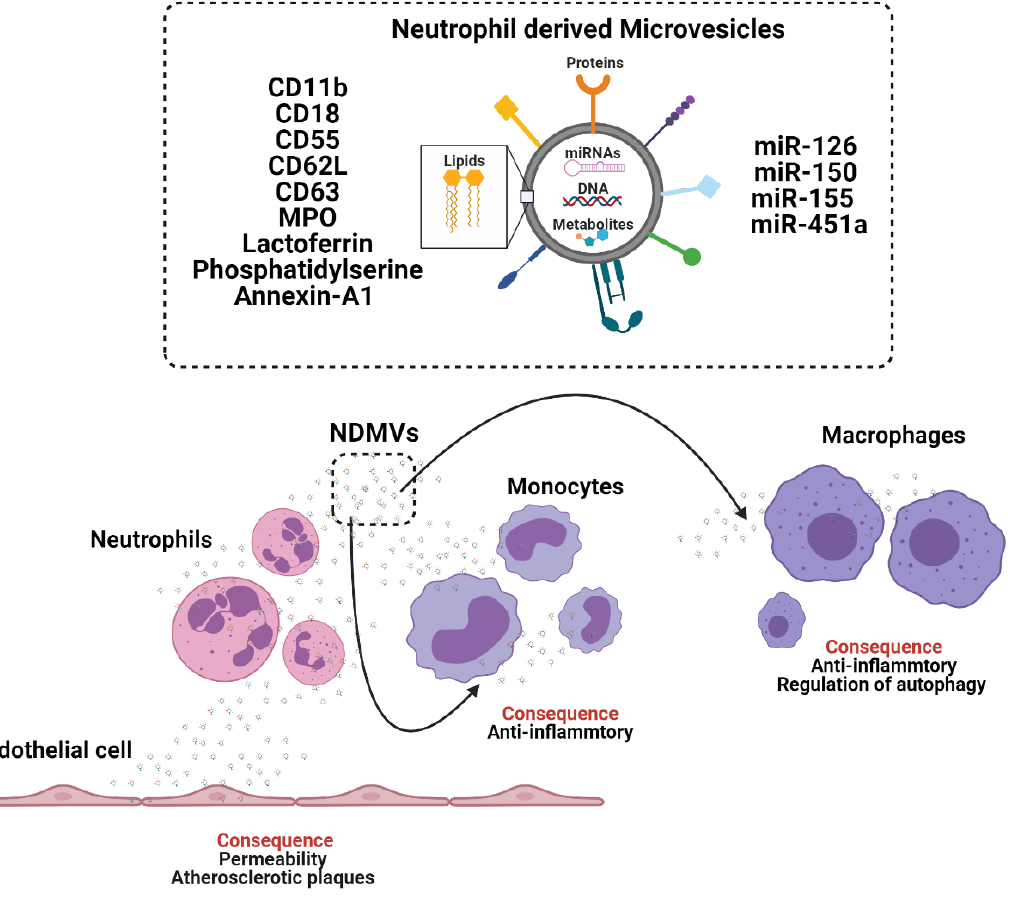
Figure 3. The crosstalk between monocytes and macrophages through the generation and release of extracellular vesicles (EV).